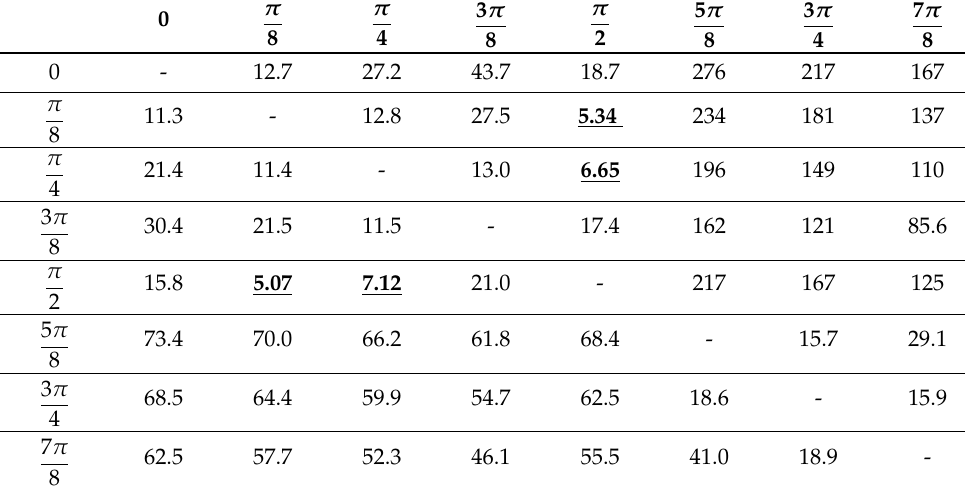
Table 11. Percent error at peak between a microlensing photometric curve with Φ shown in the first row, compared to the photometric curve with Φ in the first column. Error values for R = 1 AU. Values in bold underline show where % error between the two curves is less than 5%.